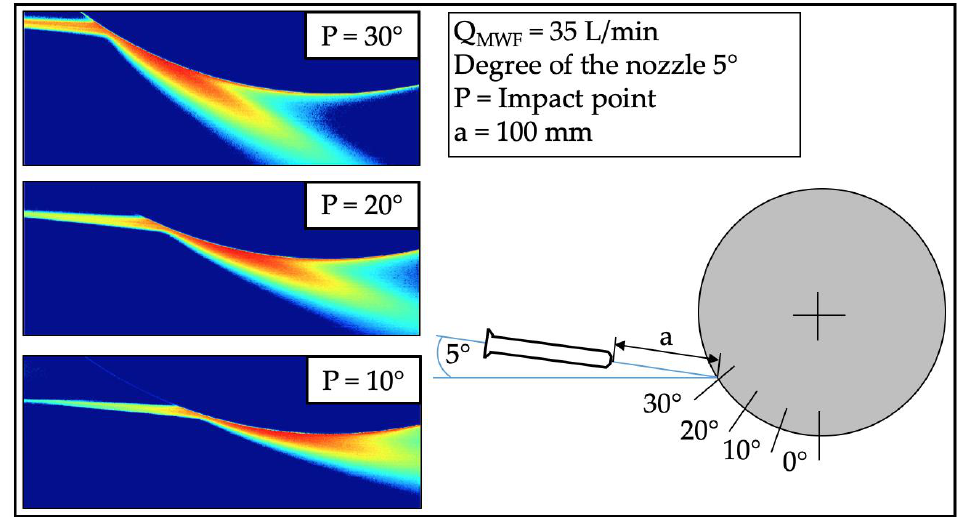
Figure 18. False-color images of an exemplary examination of the nozzle position during coolant supply.